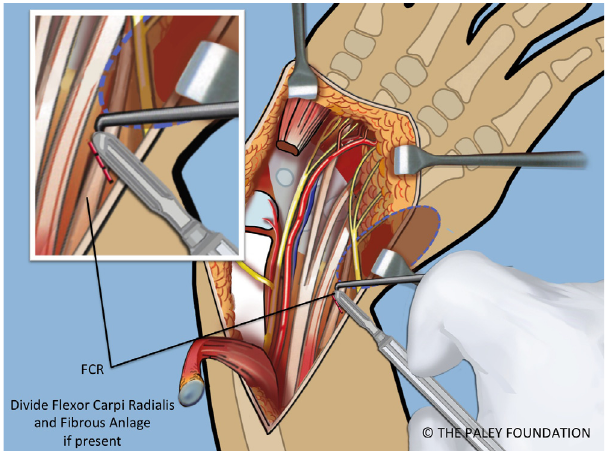
Figure 10. If the FCR is present it should be released. If a radial fibrous anlage is present it too should be released from the carpus.